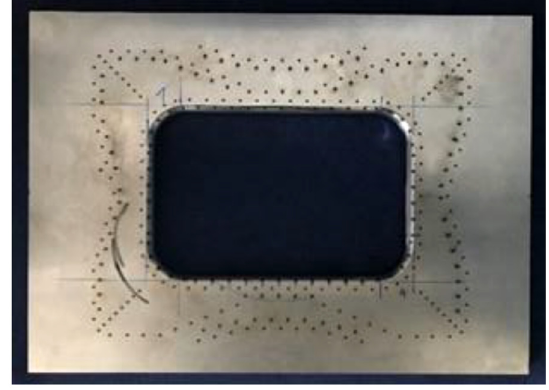
Fig. 11. Processed deep drawing